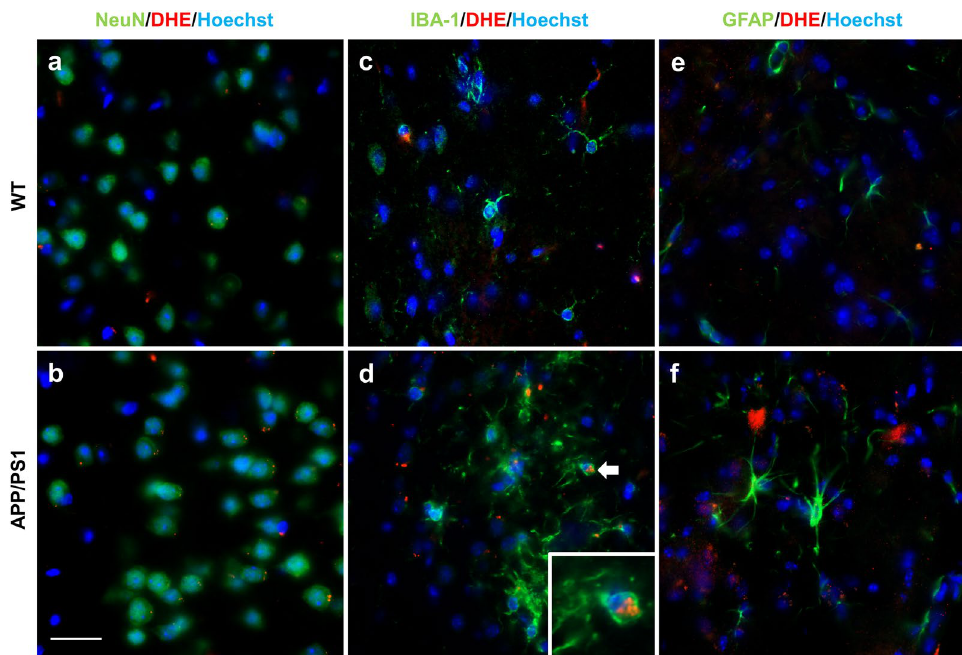
Fig. 5 DHE colocalizes with microglia and neurons, but not astrocytes, in the APP/PS1 brain. Representative confocal micrographs showing colocalization of a, b oxidized DHE (red) with neurons (NeuN; green) and c, d microglia (IBA‑1; green) in WT and APP/PS1 cortex. e, f Oxidized DHE did not colocalize with astrocytes (GFAP, green). The inlet is a magnified region of that indicated by the white arrow. Scale bar